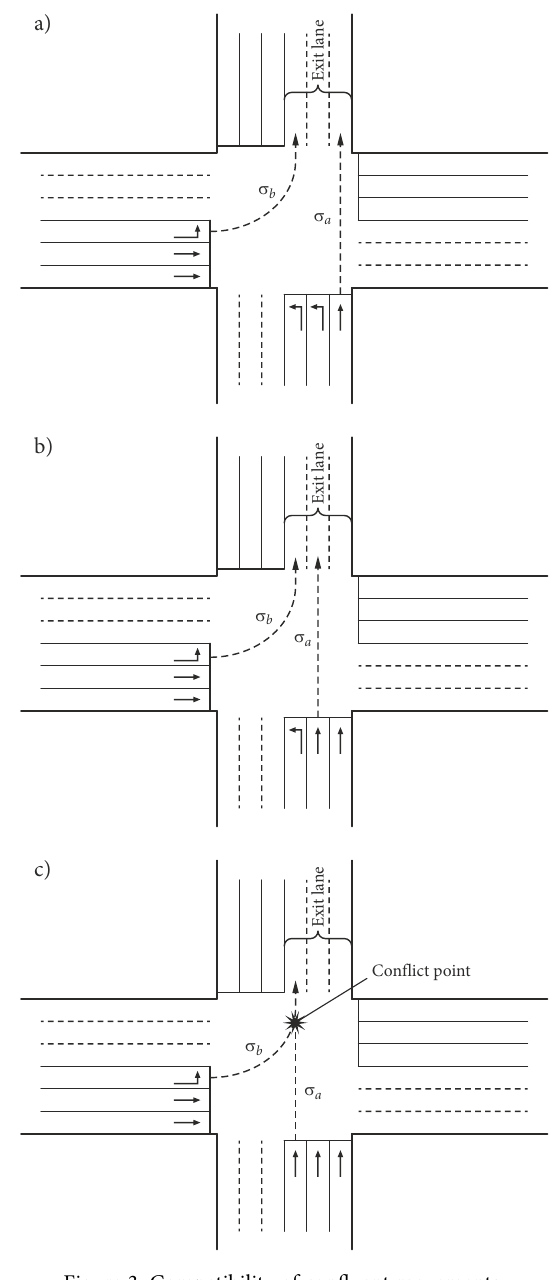
Figure 3. Compatibility of confluent